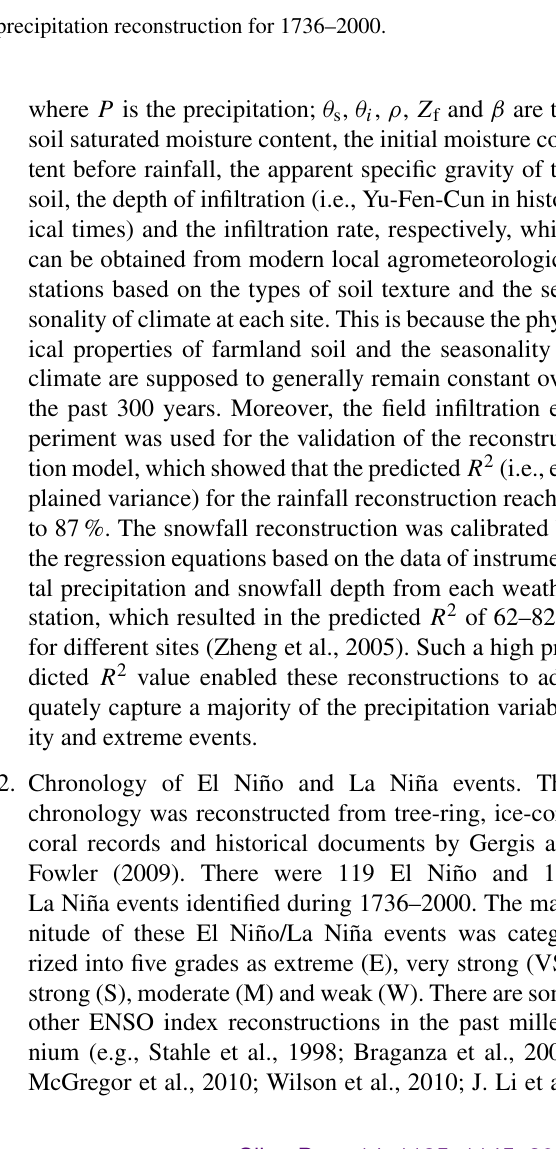
Figure 1. Map of the study area and the location of 17 sites with seasonal precipitation reconstruction for 1736–2000.